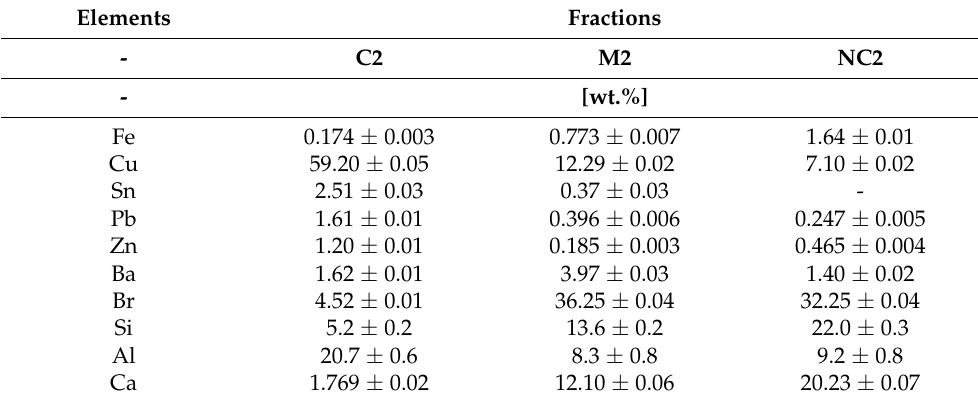
Table 8. Chemical compositions of C2, M2, and NC2 fractions.